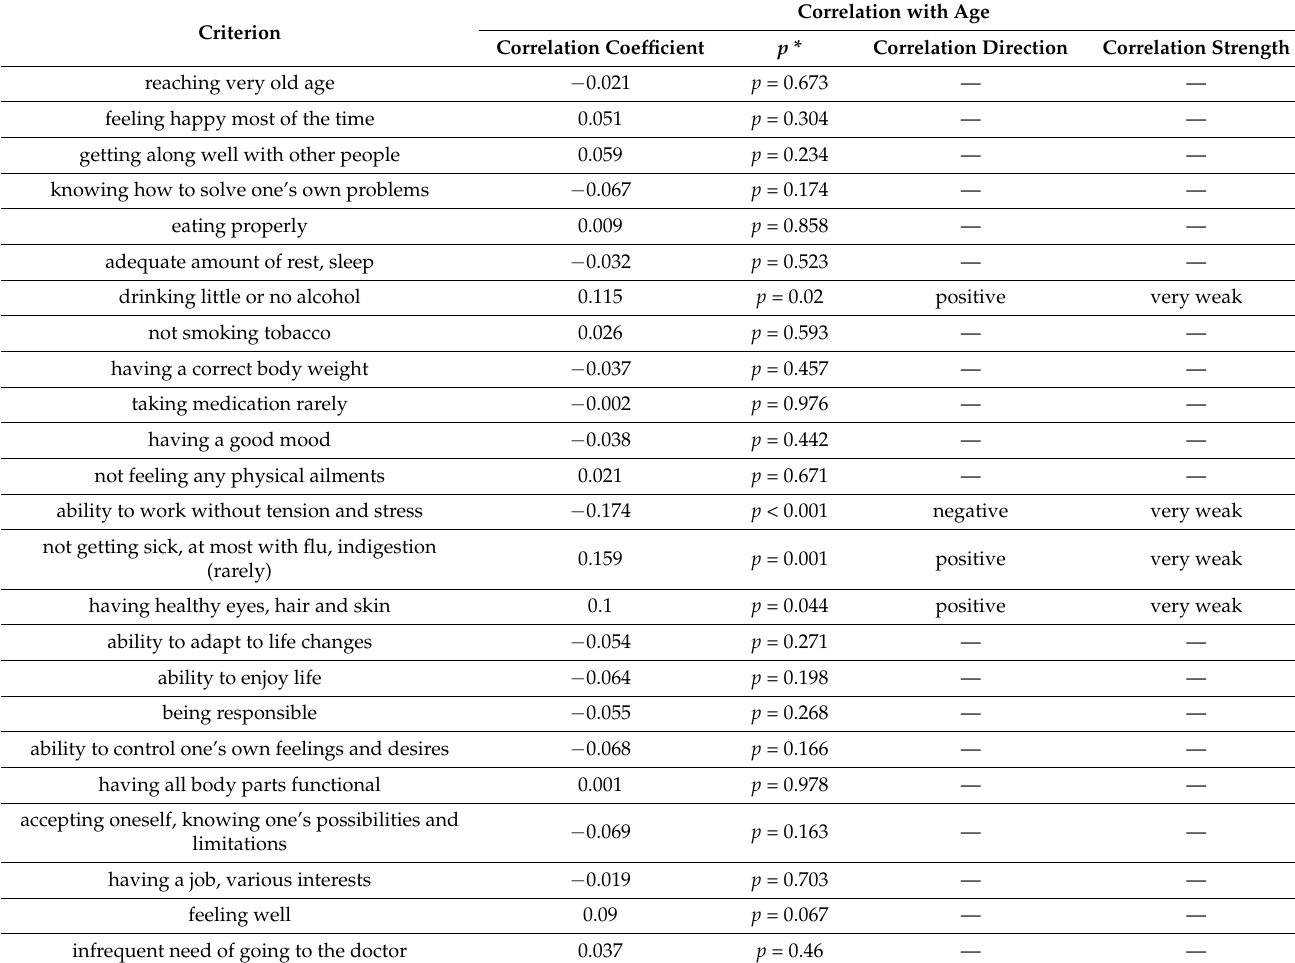
Table 3. Correlations of health statements with the age of the